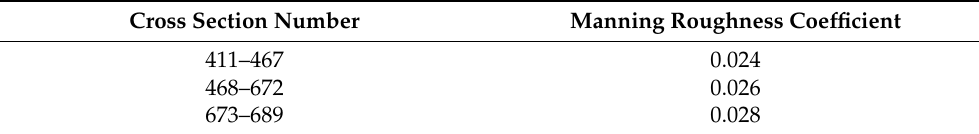
Table 6. Manning’s roughness coefficients for the hydraulic unsteady